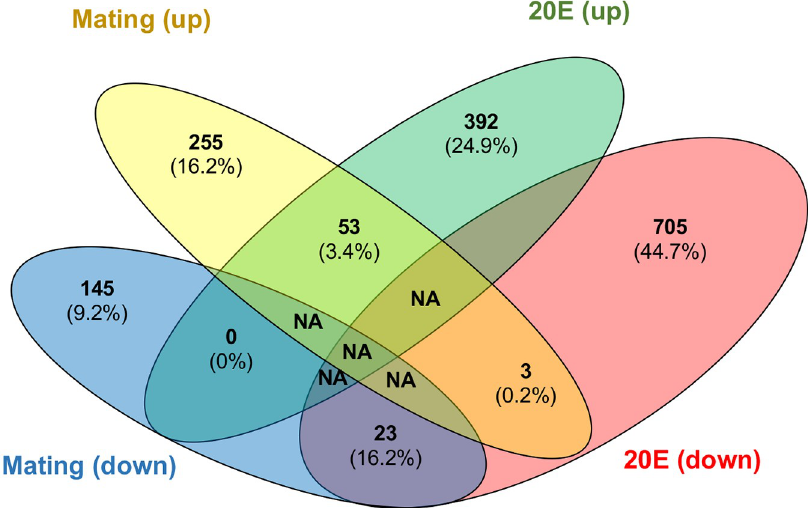
Fig 5. Venn diagram on number of genes that were upregulated and downregulated upon mating and 20E injection in sugar-fed virgin midguts. These samples were pools of 7 midguts per replicate and 5 to 6 replicates per condition. The midguts were dissected from the same batch (experiment H).